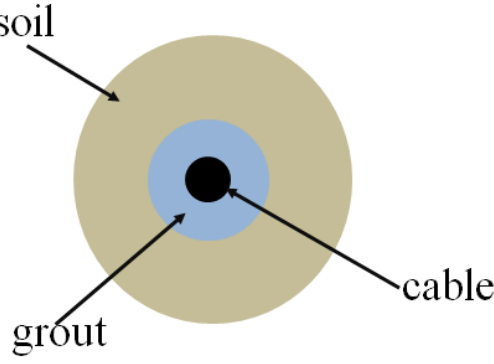
Figure 5. Modeling of the cable-grout-soil system.